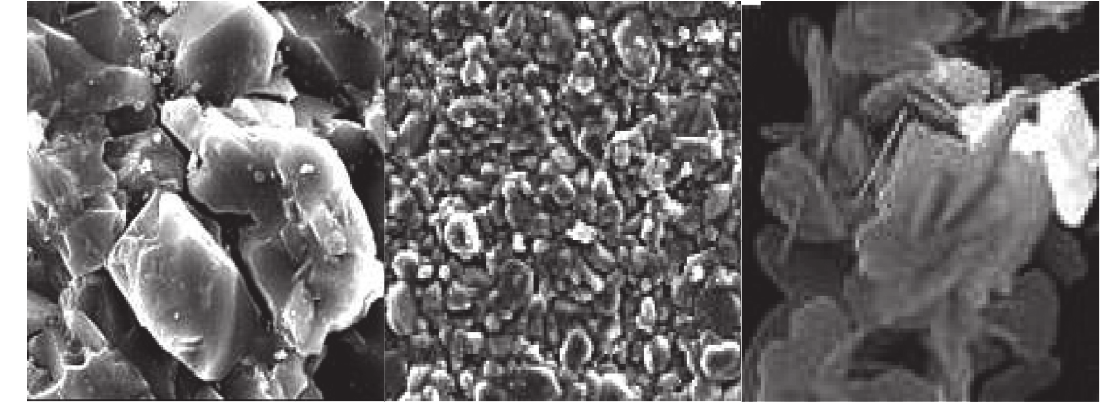
Figure 1: Alumina